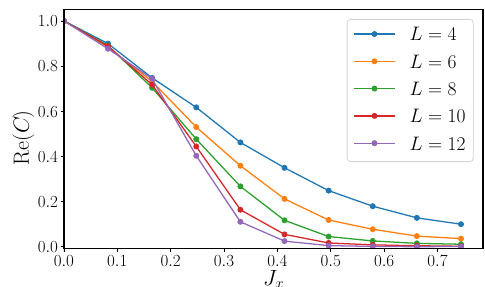
FIG. 7. Correlation function C ( r , 0; r , T / 2 ) for T (cid:3) O ( L ) in the circuit U F defined in Eq. (9). The data presented are obtained by averaging over 2560 random realizations of U F for L = 4, 6, 8, 10, and 512 random realizations of U F for L =